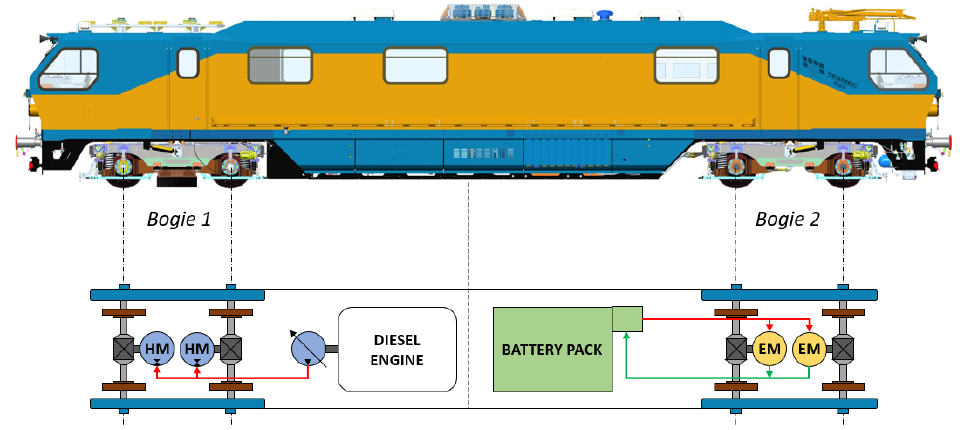
Figure 2. Proposed drivetrain layout (red lines represent power flows during propulsion, whereas green lines represent power flows in regenerative